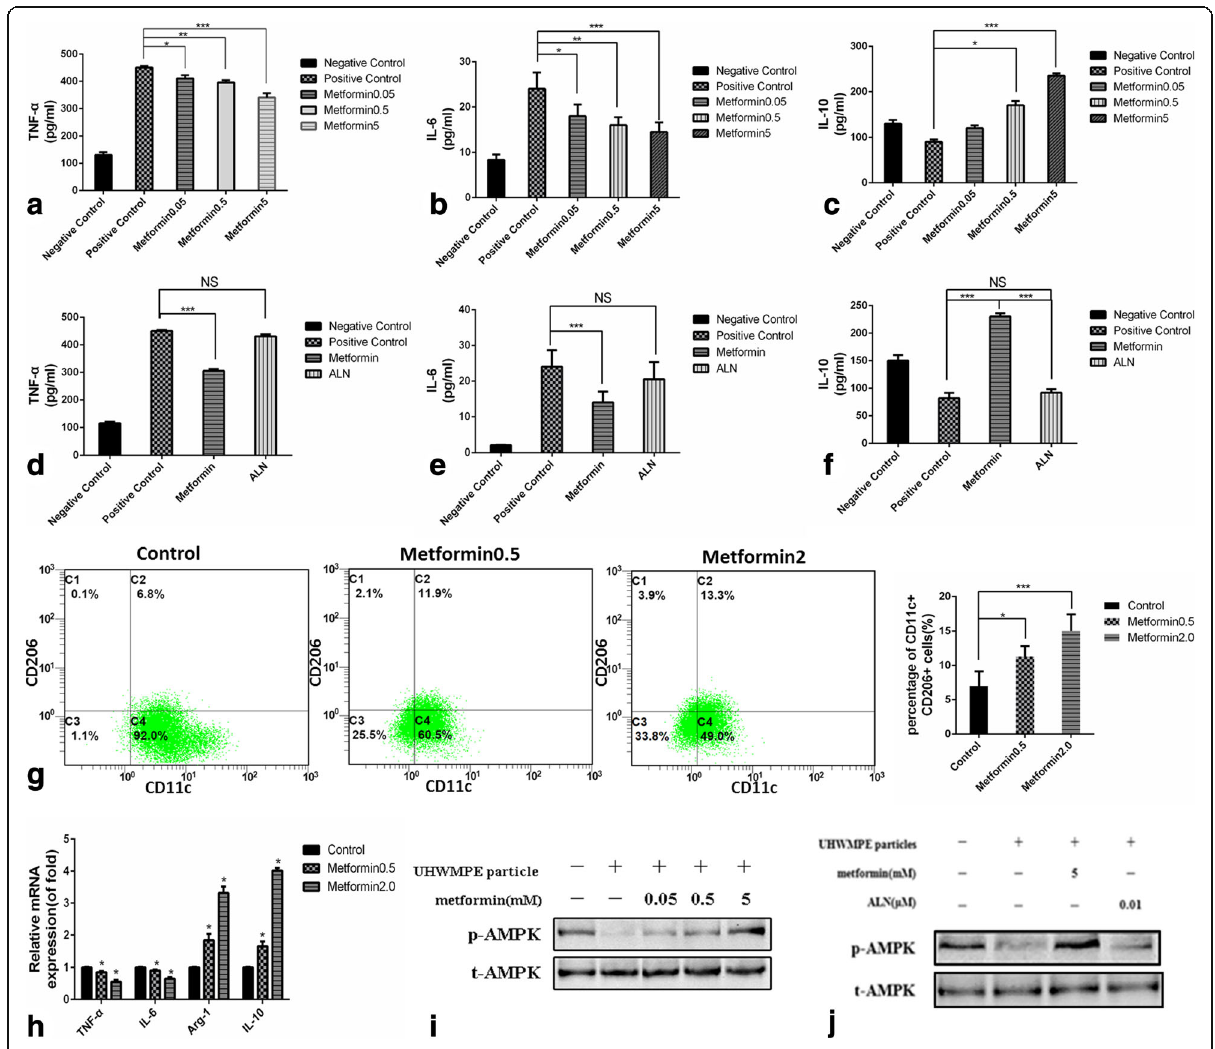
Fig. 1 Effect of metformin on primary mouse BMM cytokine production in response to UHMWPE particles and the effect on AMPK phosphorylation. Concentrations of ( a ) TNF- α , ( b ) IL-6, and ( c ) IL-10 in culture media after exposure of the cells to UHMWPE particles and various concentrations